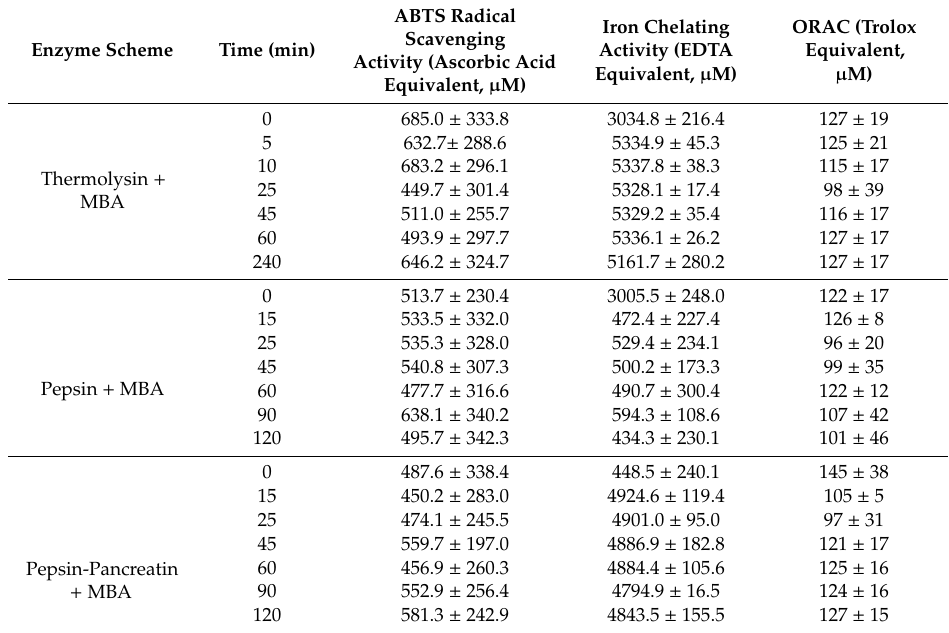
Table 3. Antioxidant Potential of Mung Bean Hydrolysates with Varying Hydrolysis Times.